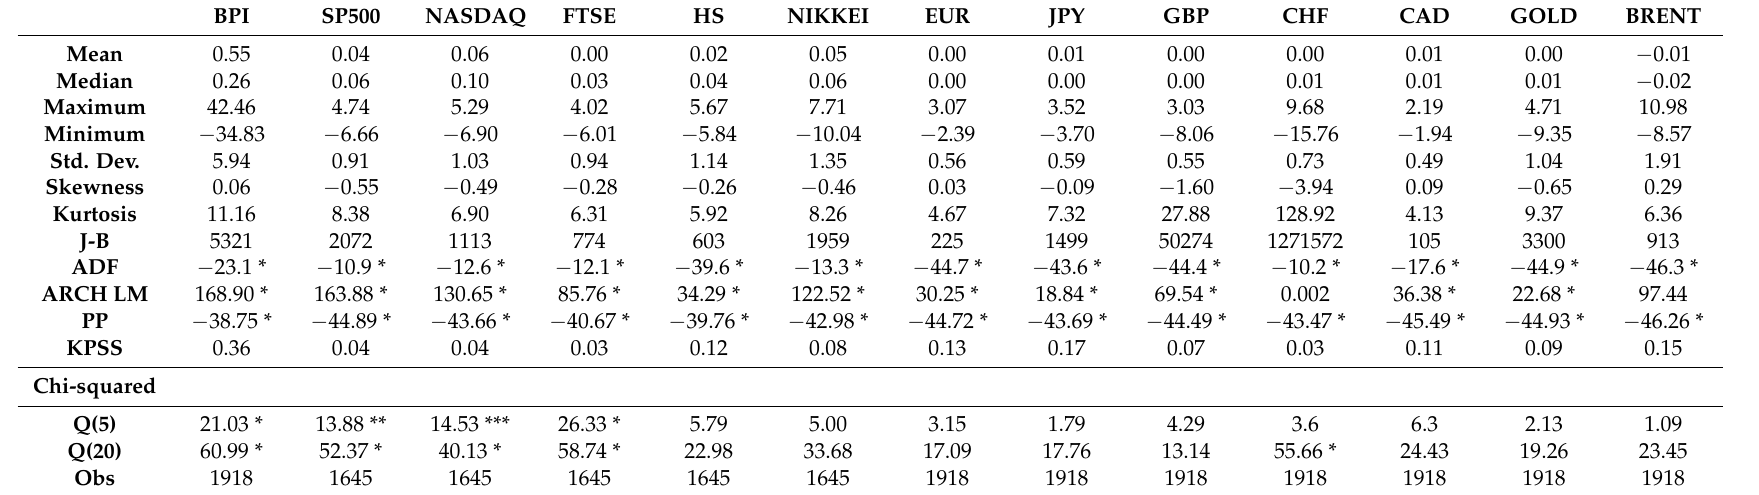
Table 1. Summary statistics of daily returns related to the Bitcoin index (BTI) and several asset